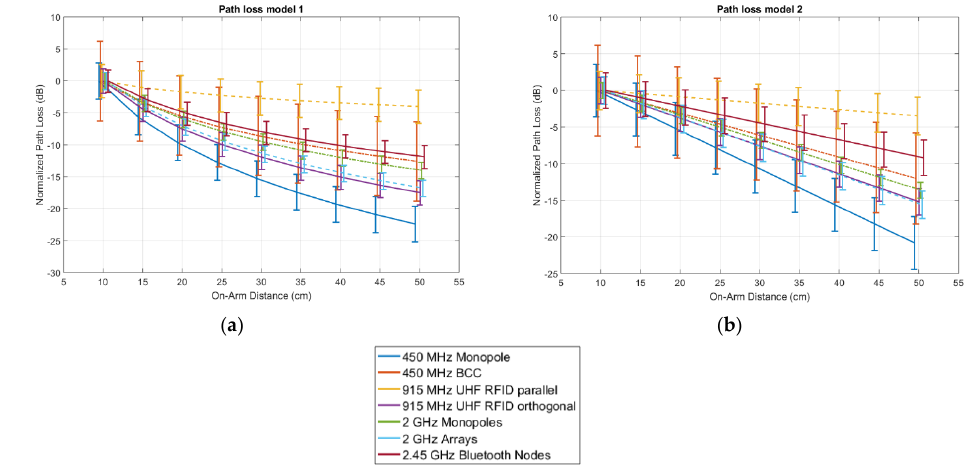
Figure 10. Normalized path loss models as a function of distance in the reference scenario (left arm) for the seven studied configurations: ( a ) Model according to Equation (1), ( b ) Model according to Equation (2). The solid lines indicate the models described in Table 2, while the whiskers are standard deviations (whiskers are shifted slightly to increase figure clarity).